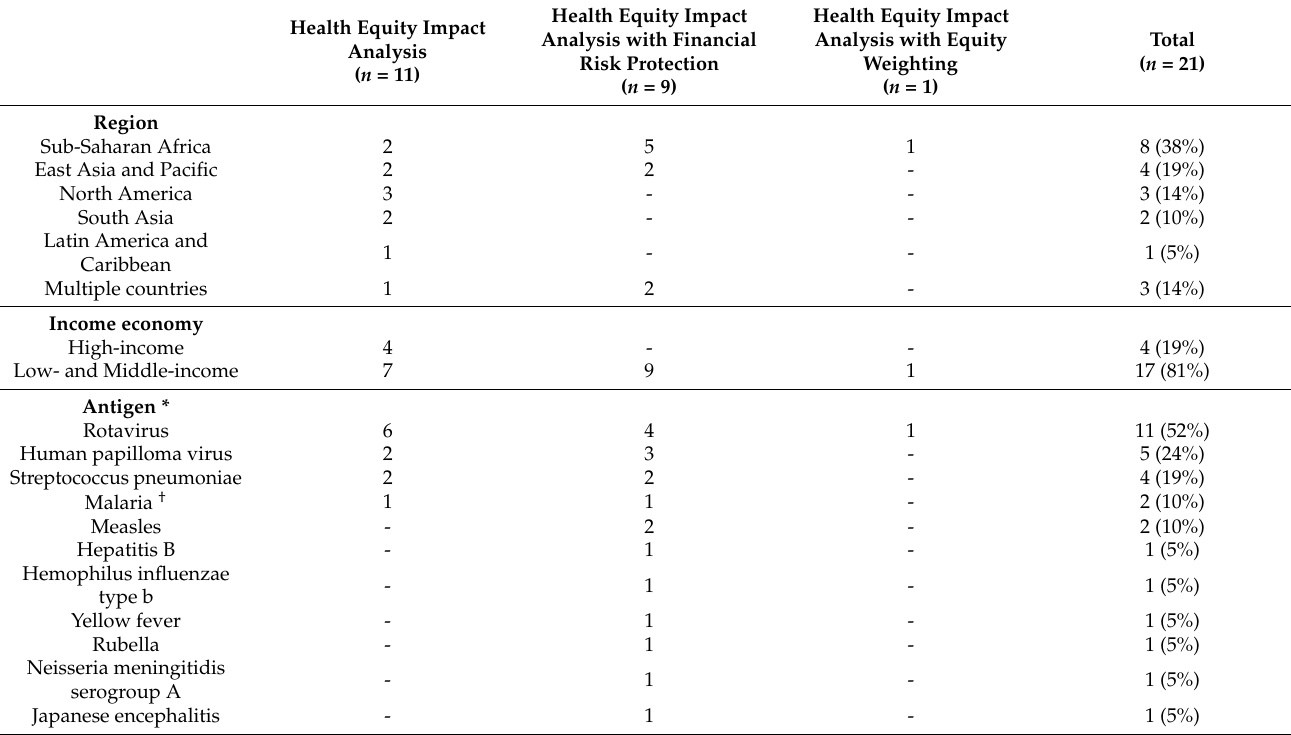
Table 1. Summary of included studies.